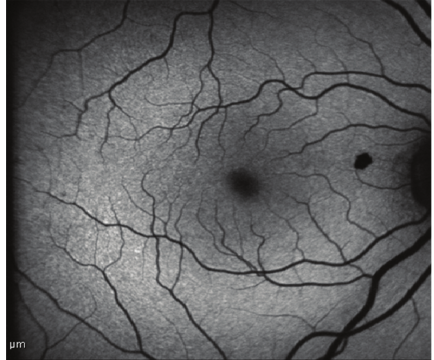
Figure 4: Fundus autofluorescence imaging showed obscurenesse of the background autofluorescence at the site of the